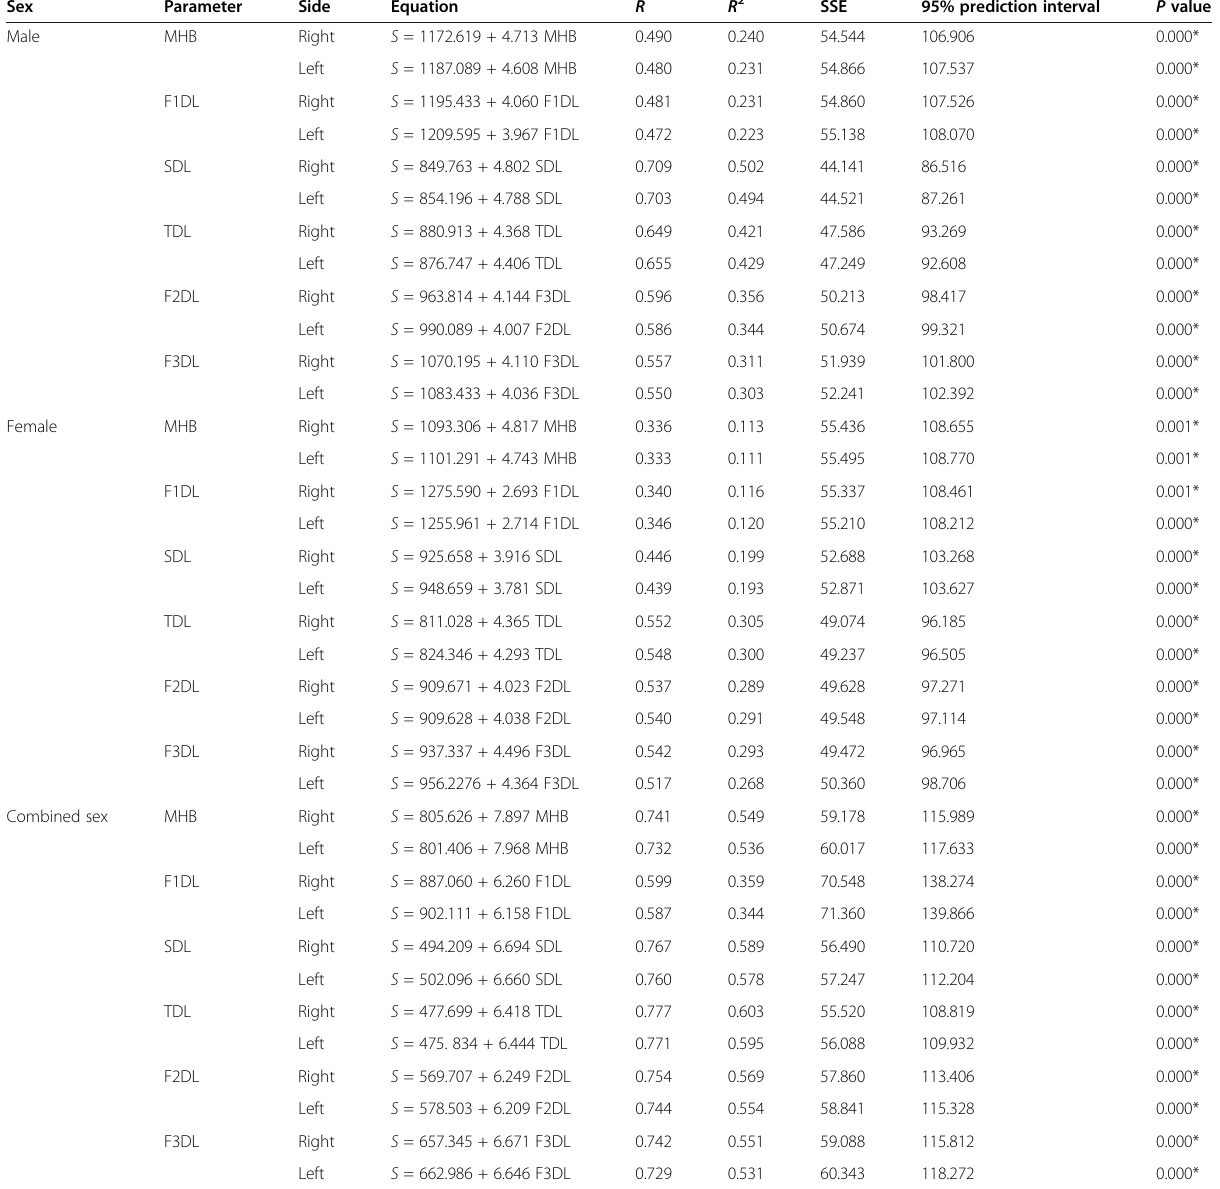
Table 3 Linear regression equations to estimate the stature from handprint measurements (in mm) Sex Parameter Side